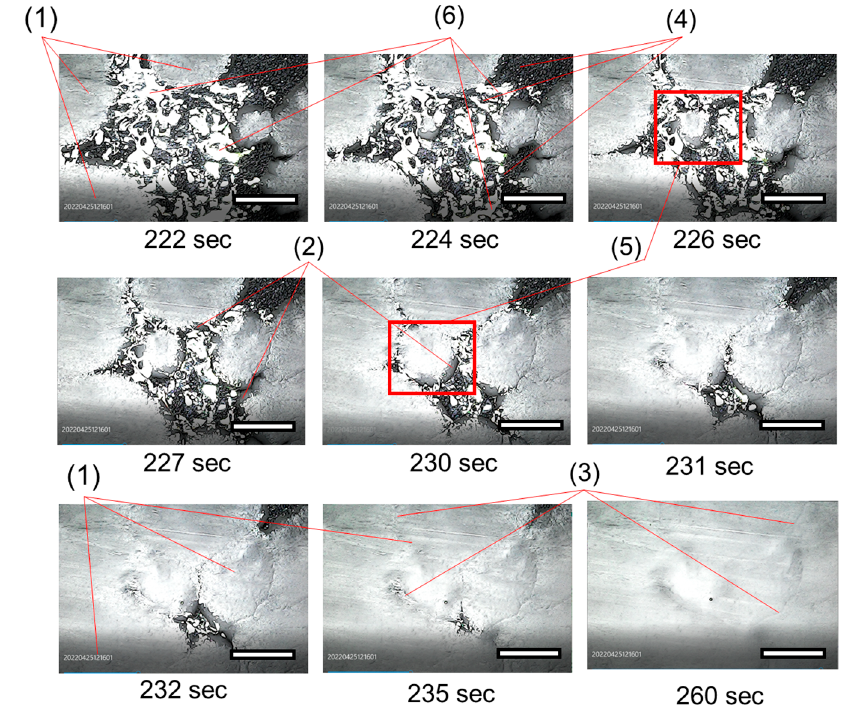
Figure 4. Photo image of growing crystallized areas during the membrane formation at − 10 ◦ C (the length of the scale bar (horizontal) 5mm): ( 1 )—crystallized areas, ( 2 )—transitional areas, ( 3 )—contact borders, ( 4 )—PVDF solution, ( 5 )—growing crystallized area (red square), ( 6 )—glare from a light